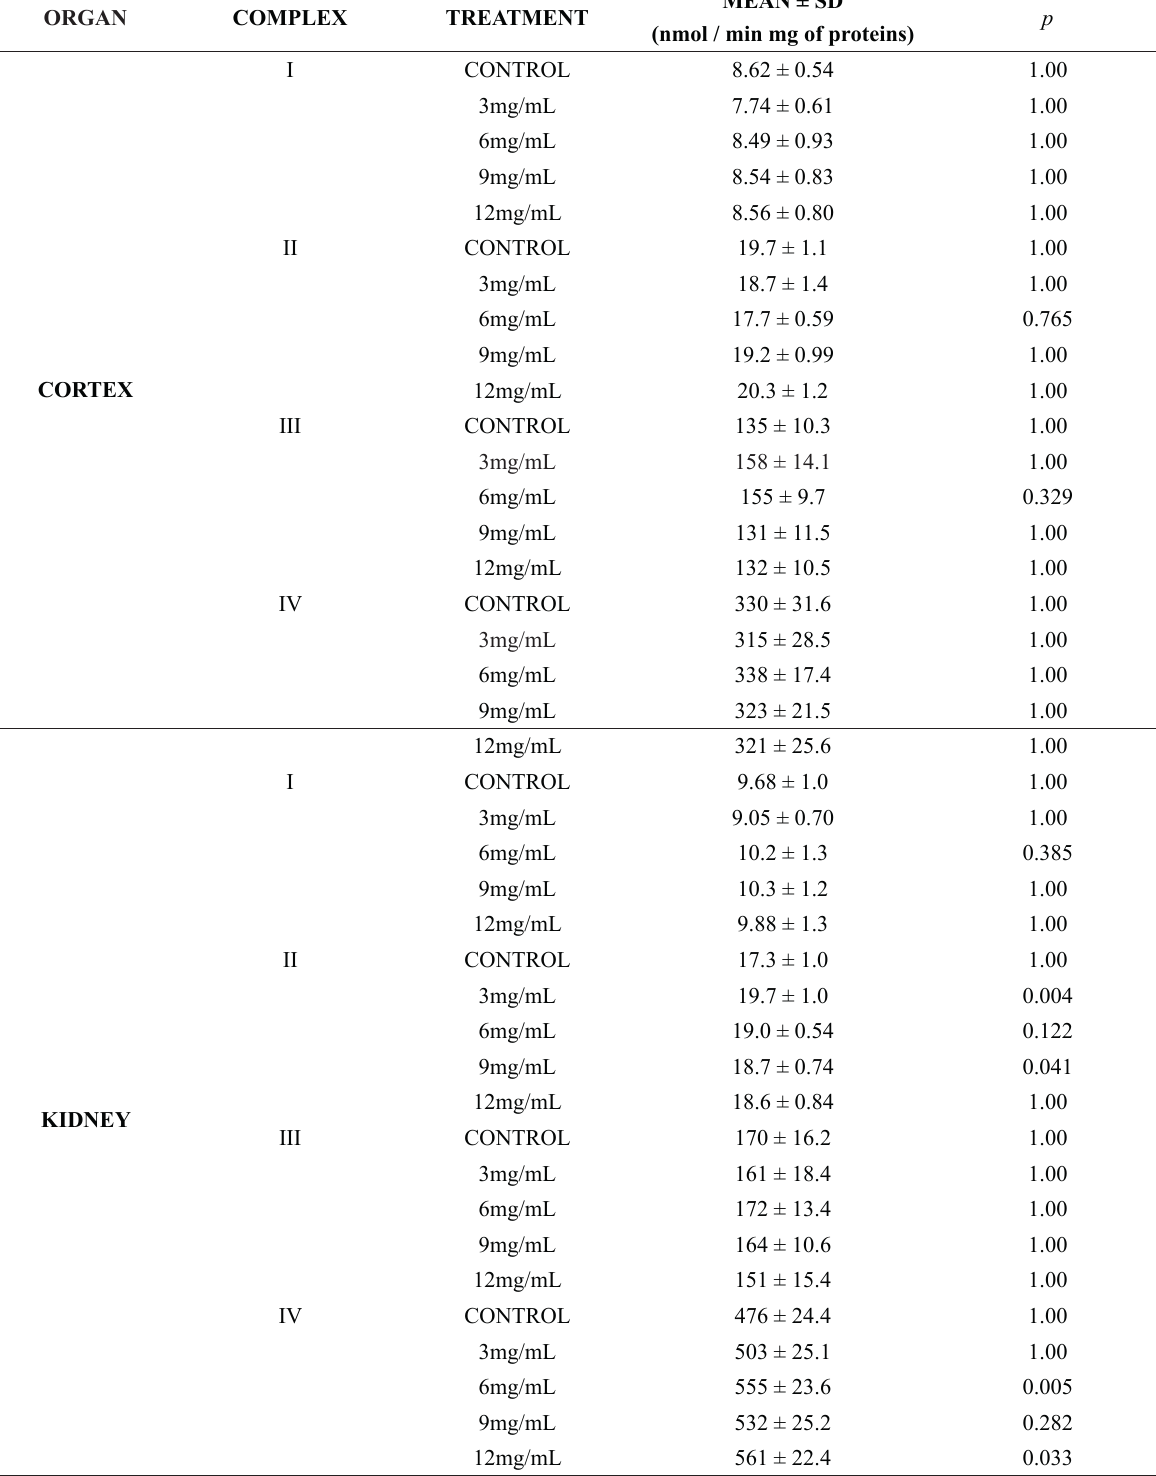
In vitro effect of GB3 treatment on complexes I, II, III and IV activity in each animal organ. ORGAN COMPLEX